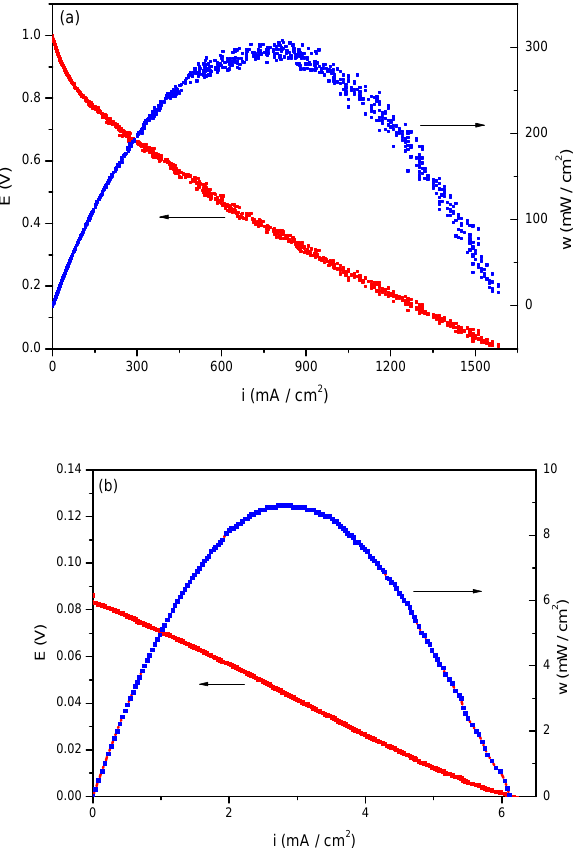
Figure 3. Polarization curves of a microtubular SOFC prototype at 500 °C, ( a ) at a stable OCV and ( b ) after a hydrogen leak was